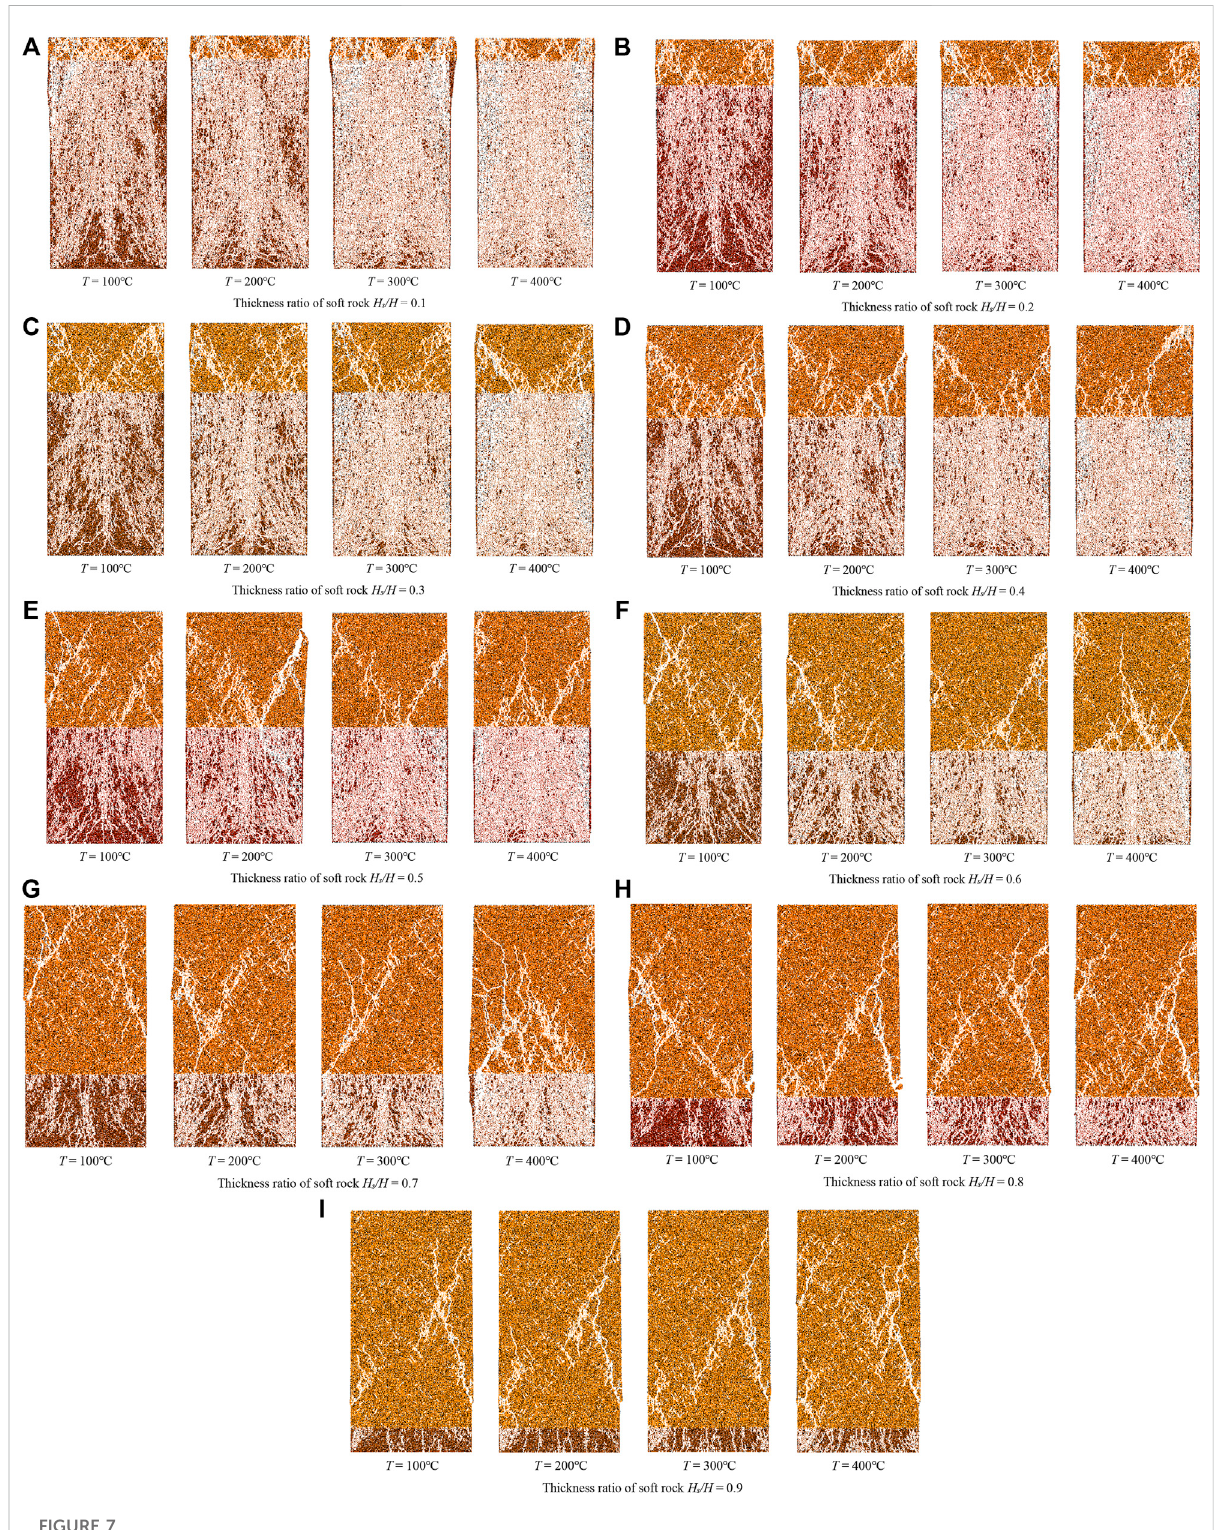
FIGURE 7 Crack development under different working